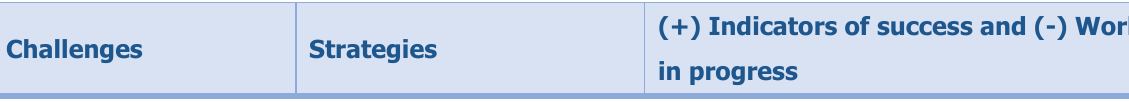
Table 8. Program Curriculum & Instruction Essentials—Teens as Teacher Essential